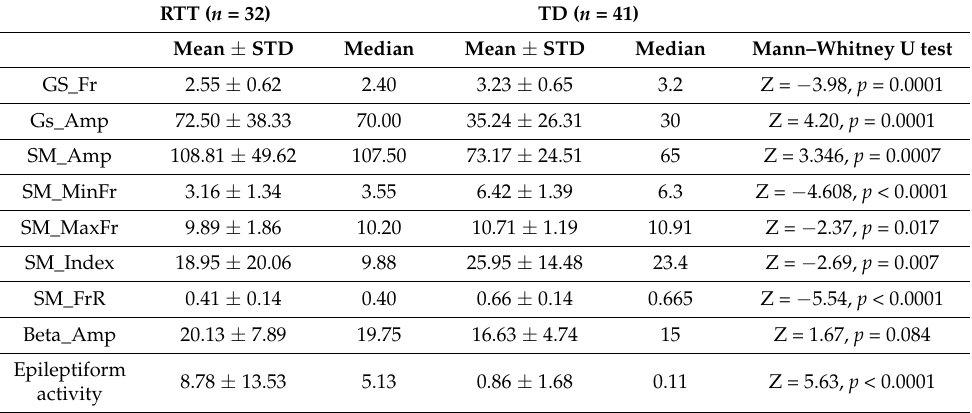
Table 4. EEG parameters in patients with Rett syndrome (RTT) and typically developed (TD) children. Following EEG parameters are presented: general slowing (GS), sensorimotor rhythm (SM), beta rhythm and EEG abnormalities. Max—maximal, Min—minimal, Fr—frequency, FrR—frequency rate as the ratio between high-frequency and low-frequency waves, Amp—amplitude, Index—the percentage of EEG parameters to the whole analyzed EEG